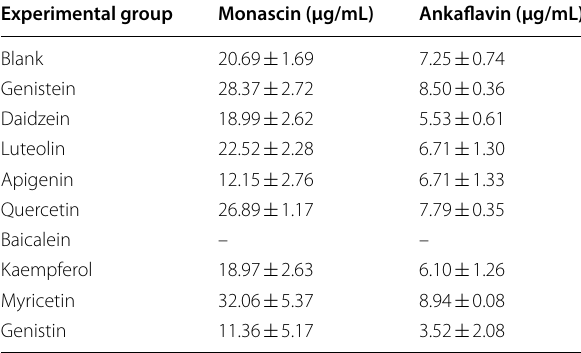
“–” means no detection